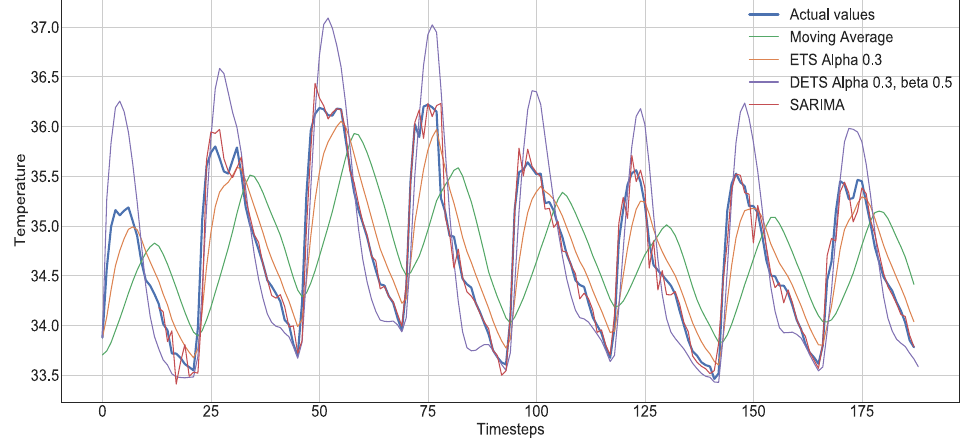
Figure 3. Forecasts of some of the statistical methods on a seasonal example time